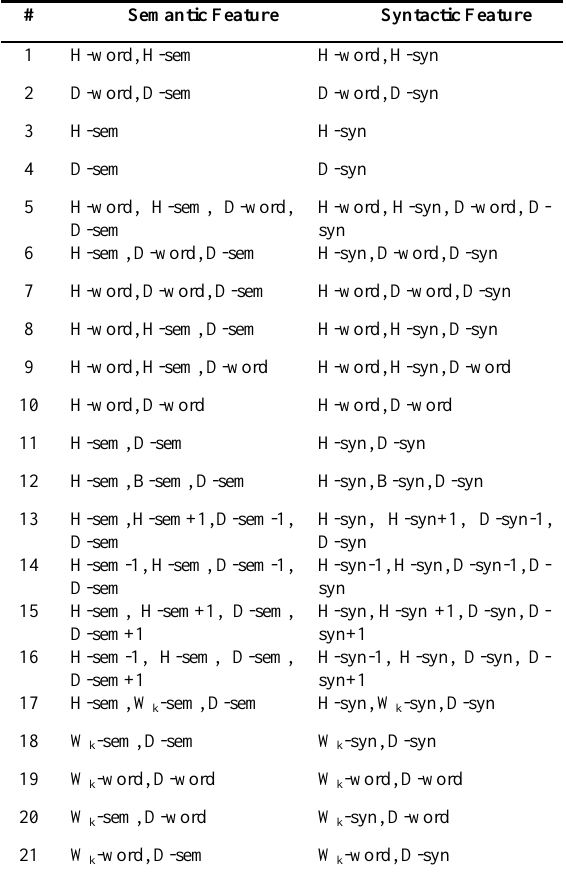
Table 1. List of semantic and syntactic features for head word (H) and its dependent (D), words between H and D (B) and sibling words of D between H and D (w k